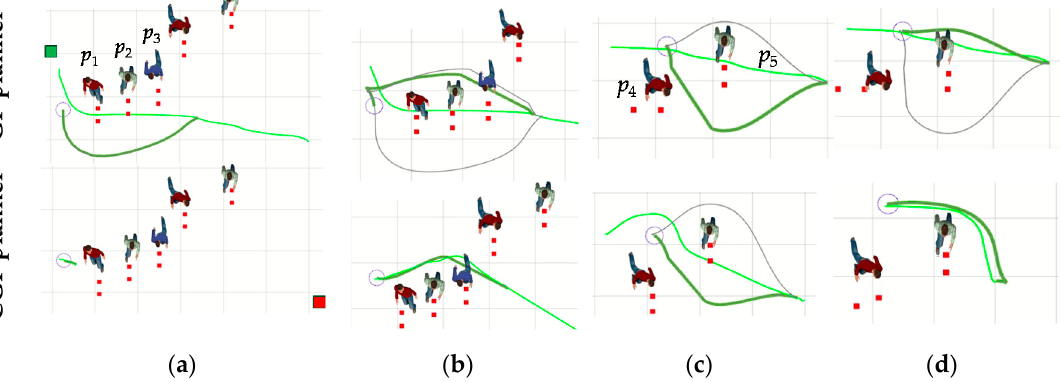
Figure 8. The trajectory planning process of avoiding five pedestrians with GP and CGP planners: ( a , b ) Avoiding p 1 , p 2 , and p 3 ; ( c , d ) avoiding p 5 .The average velocity of the robot with the GP planner is 1.25 m/s, and the evaluation function value of the trajectory is 62.5; while the average velocity with the CGP planner is 1.39 m/s, and the evaluation function value of the trajectory is 69.5. This shows the necessity and effectiveness of trajectory planning with chasing cost judgment, which is proposed in our approach.